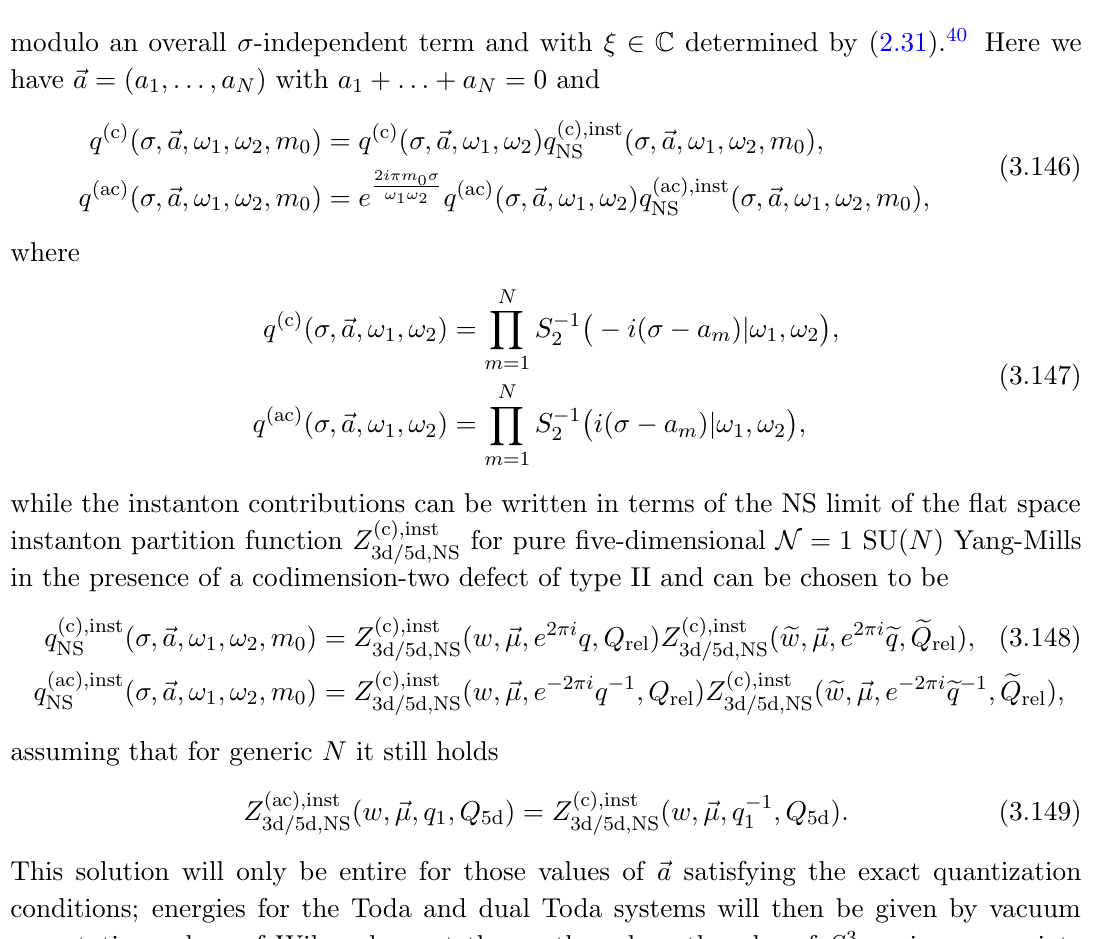
Figure 21. N = 3 Baxter solution q ( (cid:27) ) for the ground state (0 ; 0) at ! 1 = 1 p Left: numerical result; center: gauge theory result; right: di(cid:11)erence.